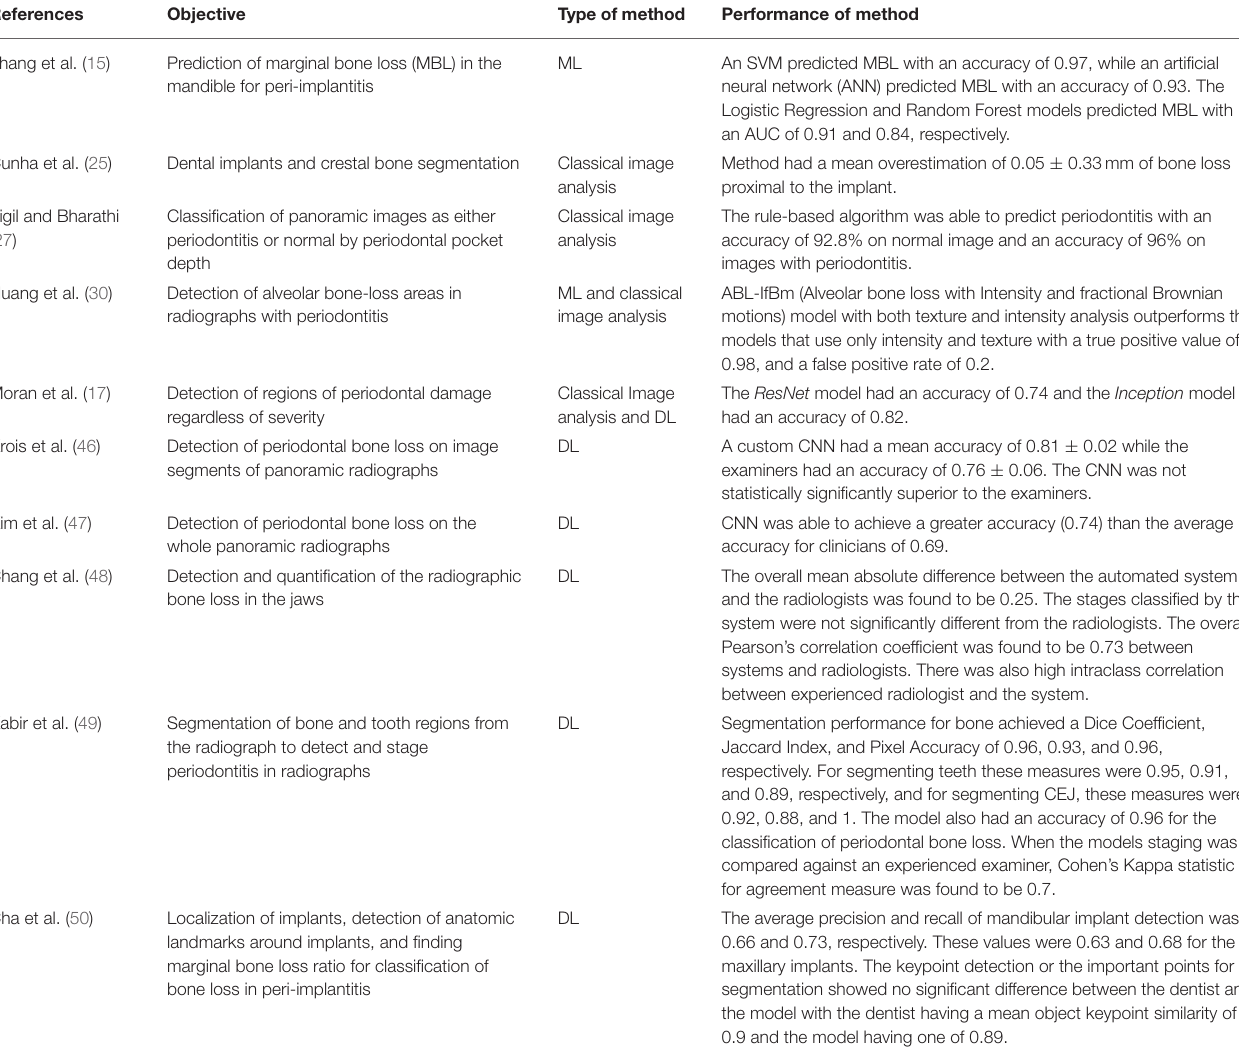
TABLE 2 | Summary of recent literature that employed computational image analysis methods on dental radiographs for periodontitis and